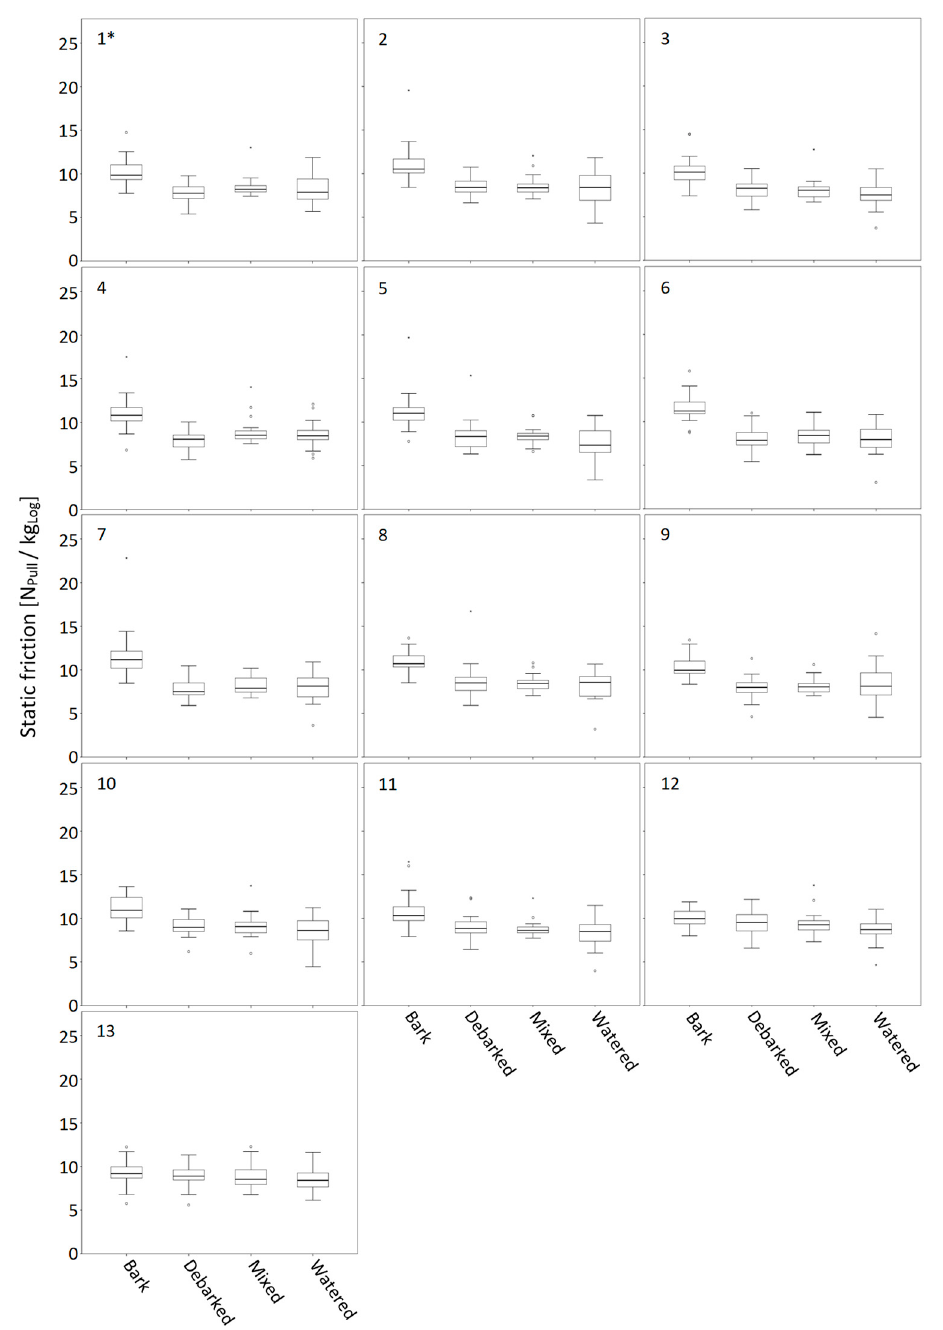
Figure 9. Development of static friction (N Pull / kg Log ) for each treatment throughout the 13 test sessions (* test number) .